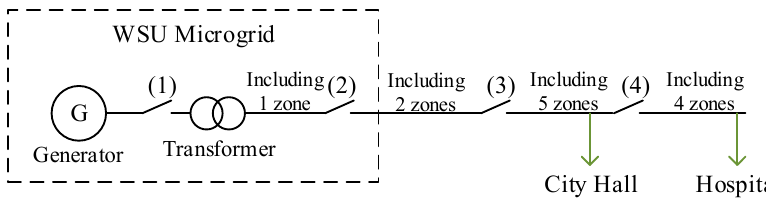
Figure 7. Restoration path from WSU generator to critical load in Pullman distribution system.